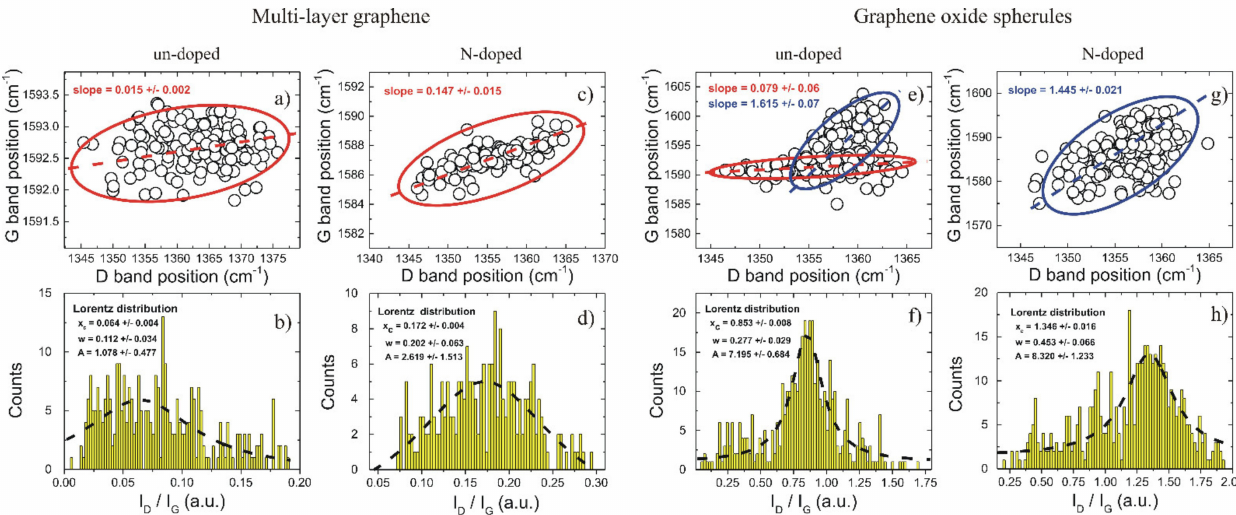
Figure 4. Raman analyses of multi-layer graphene ( a – d ) and graphene oxide spherules ( e – h ) from 25 × 25 µ m 2 scans with a 532 nm laser beam and a 20 × magnification objective lens. The position of the G and D bands are shown for both carbons, as resulted from fit to data corresponding to un-doped and N-doped specimens. The data grouped in clusters, as indicated by each ellipse, whose main axis (i.e., indicated by dashed lines) slope denotes the correlation between the data. Additionally, the histograms associated with the intensity ratios of the D and G bands are given, respectively. The dashed lines represent fits to data using one Lorentz distribution. The parameters of the Lorentz distributions (i.e., x c —peak position, w—full width at half maximum (FWHM) and A-area) are indicated